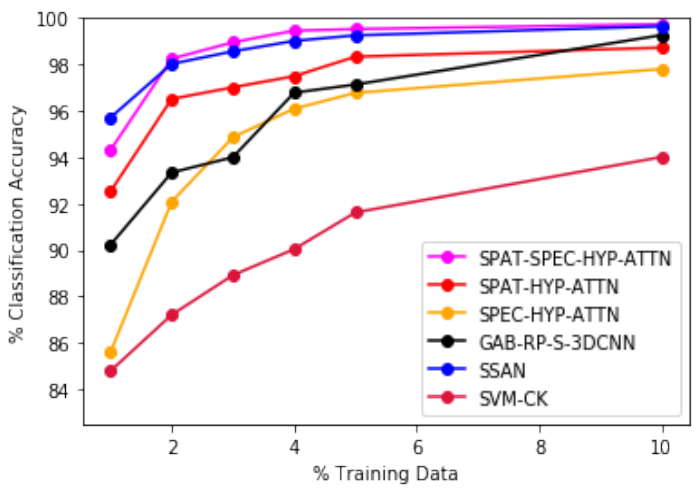
Figure 8. Overall classification accuracies of Pavia University dataset for varying size of training samples.